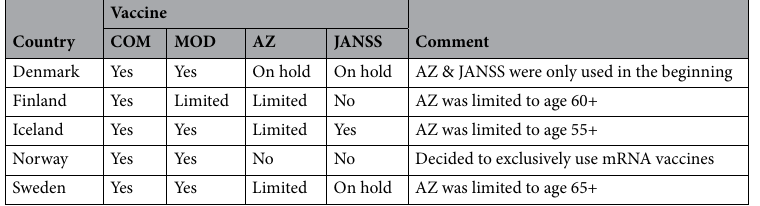
Table 1. Overview of the vaccine types used in the Nordic countries.